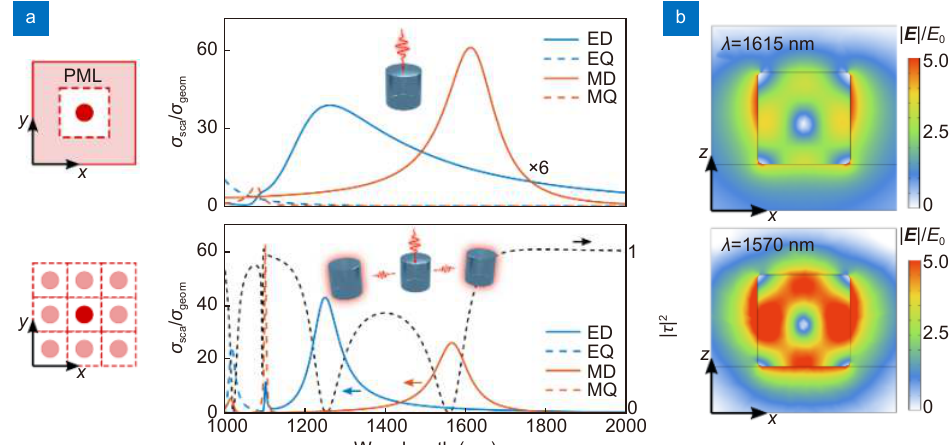
Fig. 2 | Comparison between isolated (top) and arrayed (bottom) air-suspended GaAs nanoantennas with radius r = 200 nm and height h =400 nm. A normally impinging beam is linearly polarized along x , and the array (bottom) has a period of p =1 μm. ( a ) Scattering cross section decomposed in electric (blue) and magnetic (red) multipolar contributions, computed by projecting the field inside a nanoparticle onto vector spherical harmonics 95 . The scattering cross section from the isolated particle has been scaled by a factor 6 to be compared with the plot on the bottom. The black dashed curve (bottom) displays the array transmission. ( b ) Near-field enhancement corresponding to the magnetic-dipole resonance.